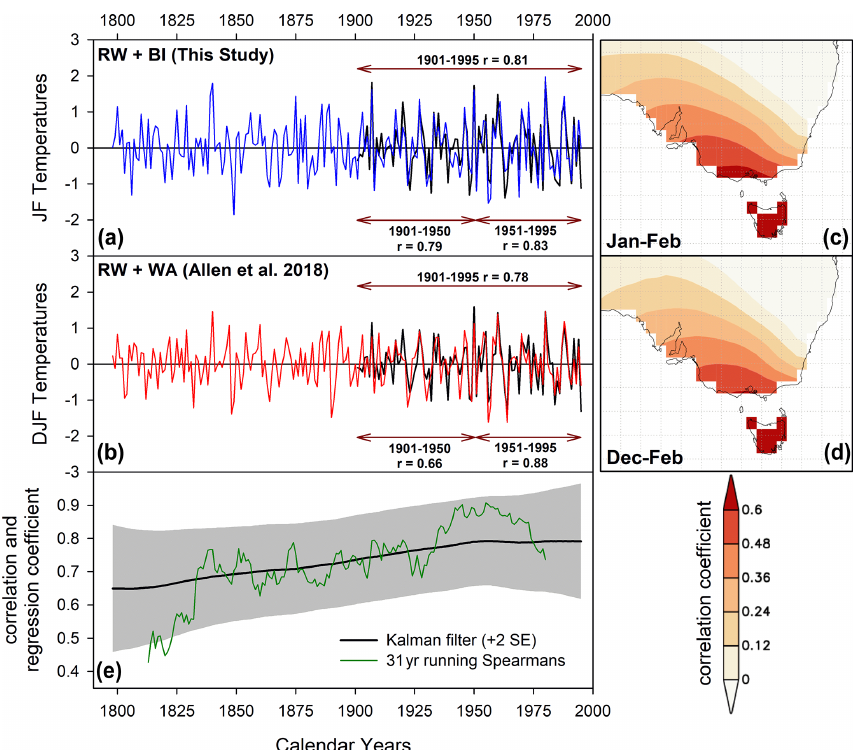
Figure 5. (a) Variant 2 (full-period-screened) Tasmanian JF temperature RW + BI parameter-based reconstruction with CRUTS temperature data. Pearson’s correlation is shown for the 1901–1995, 1901–1950, and 1951–1995 periods. (b) As A, but for Allen et al. (2018) RW + WA Tasmanian DJF temperature reconstruction. These data have also been high-pass filtered using a 20-year cubic smoothing spline. (c, d) Spa- tial correlations (1841–1995) between each reconstruction and similarly detrended Berkeley gridded data for the January–February and December–February seasons respectively; E: running 31-year Spearman rank correlation and Kalman filter analysis (Visser and Molenaar,